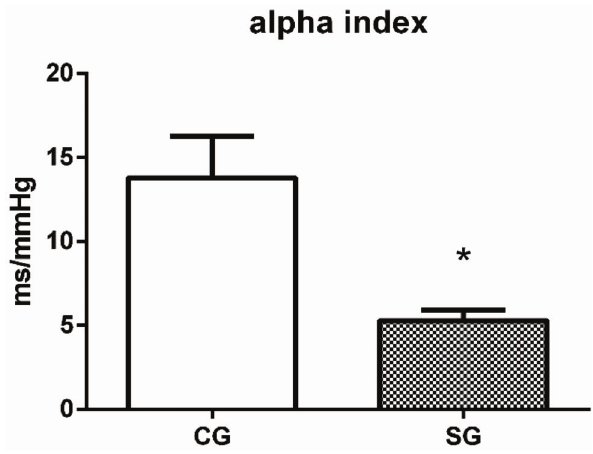
Figure 2 - Baroreflex sensitivity (alpha index). CG: control group. SG: stroke group. Student ’ s t test. * p o 0.05 vs. CG.